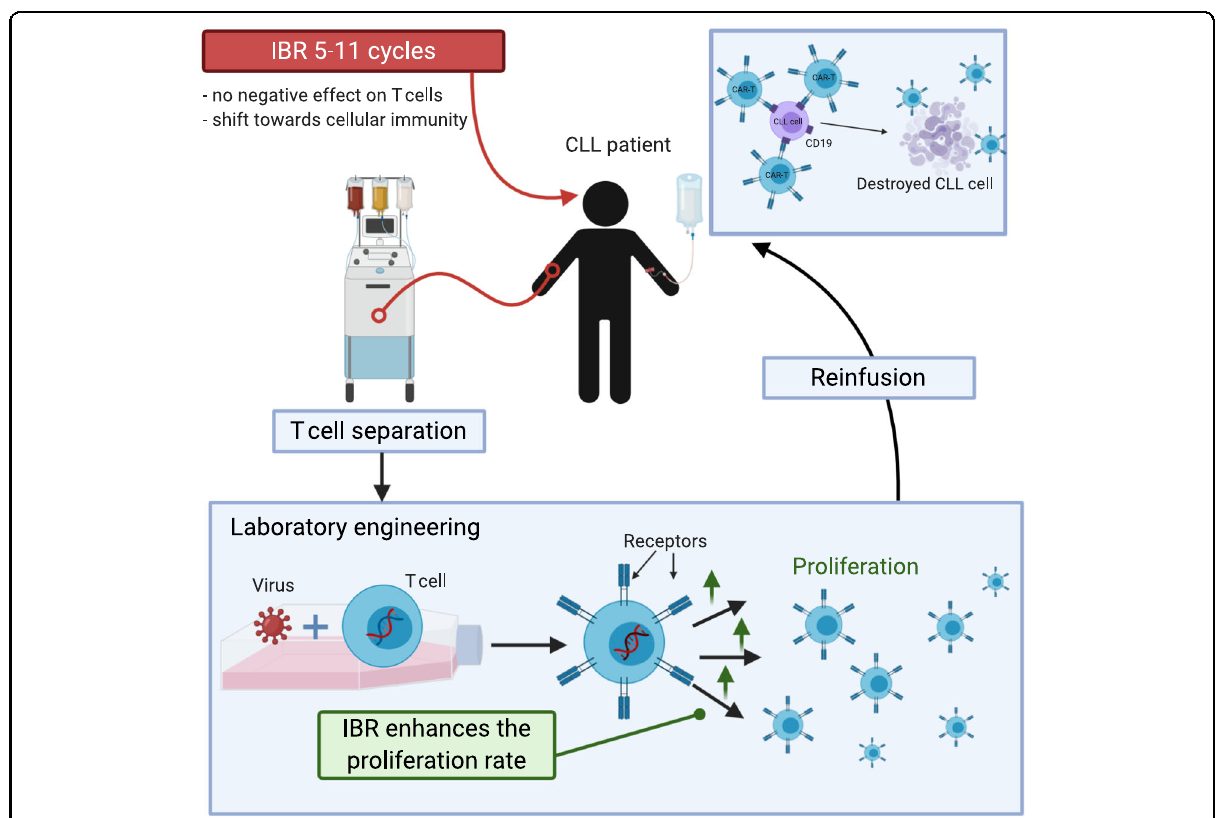
Fig. 3 Rationale for ibrutinib combination with cell therapy. Unlike several commonly used treatments (chemotherapy, alemtuzumab), ibrutinib (IBR) does not have a profound negative impact on T cell function. Due to off-target effect of ibrutinib on ITK, there is a shift towards cellular immunity (Th1 ↑ , Th2 ↓ ). Ibrutinib therapy for fi ve to 11 cycles before T cell separation leads to an increased CAR-T cell proliferation rate. The mobilizing effect of ibrutinib may make CLL cells more accessible to CAR-T cells. This fi gure was created with